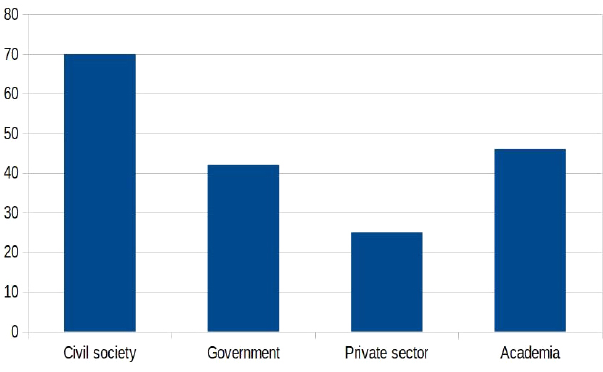
Fig. 5. Number of collaborators (alters) per sector of